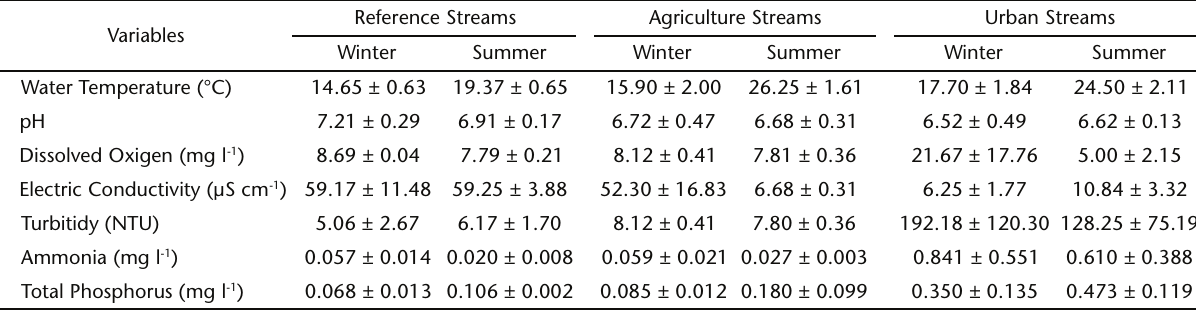
Table II. Average values and standard deviation of the environmental variables measured in streams (Erechim, Rio Grande do Sul, Brazil).